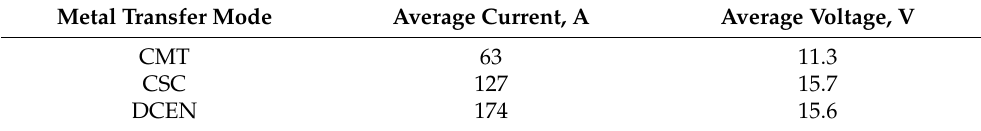
Table 1. Average current and average voltage values during CMT, CSC, and DCEN transfer processes. Metal Transfer